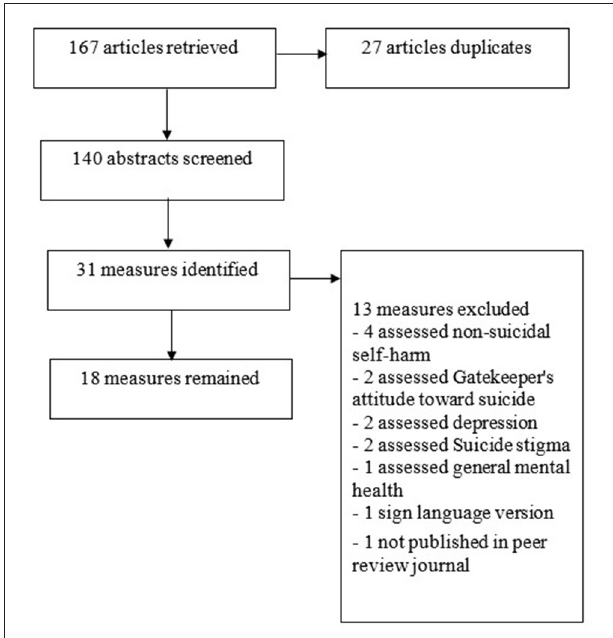
FIGURE 1 | Flow diagram of the systematic review to identify suicide